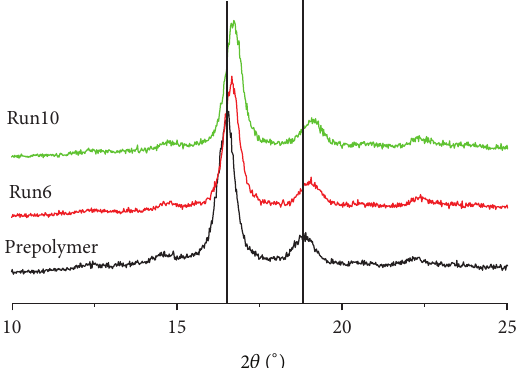
Figure 8: XRD pattern of the PLA prepolymer and the chain- extended